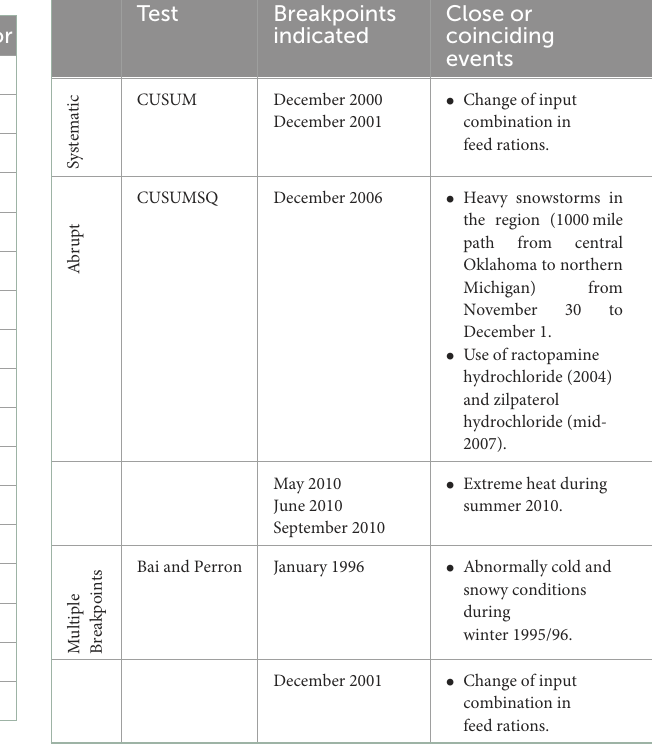
TABLE 3 Parameter estimates for Kansas feedlot death loss rate model (Equation 1), January 1992–July 2017.